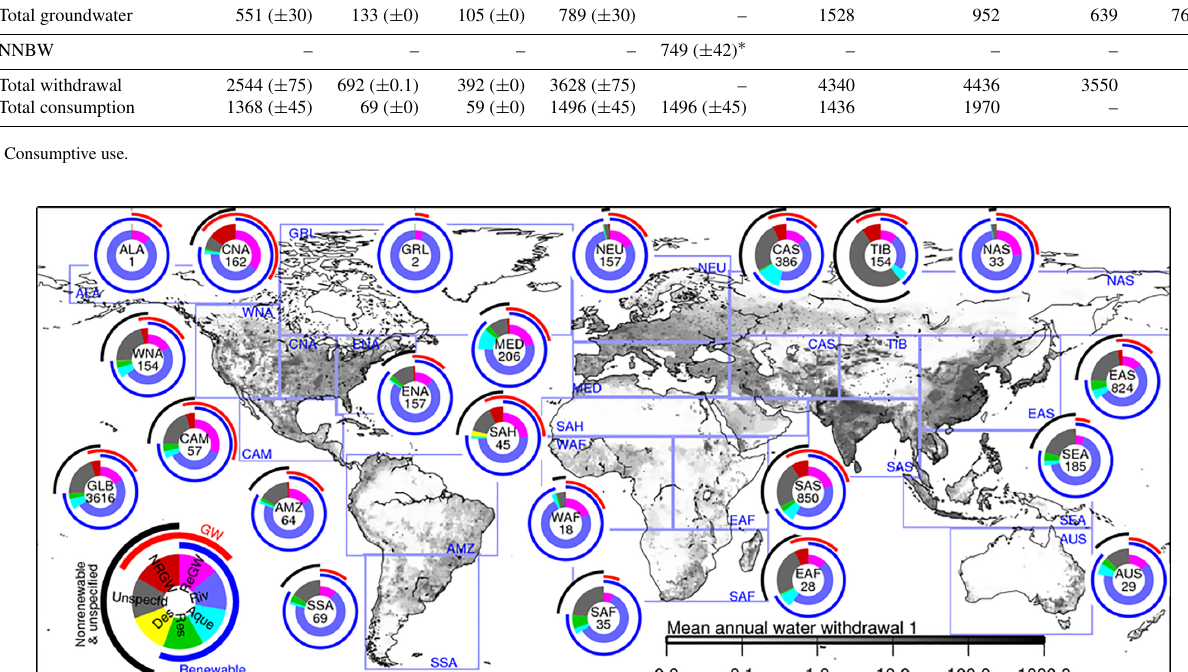
Figure 11. Water sources by region. The global map shows the mean annual total water withdrawal of this simulation. The world is separated into the 21 regions proposed by Giorgi and Francisco (2000). See Table S2 for the full names of the abbreviated regions. For each region, the fractional contribution of each water source is shown in the inner circle: magenta for renewable groundwater, light blue for rivers, cyan for aqueducts, light green for local reservoirs, yellow for seawater desalination, gray for unspecified surface water (USW), and dark red for nonrenewable groundwater. The outer arcs show the aggregated information. Red, blue, and black arcs show the fractional contribution of groundwater, renewable water, and nonrenewable water and USW. The numbers in the circles show the total water withdrawal of the regions in km 3 yr − 1